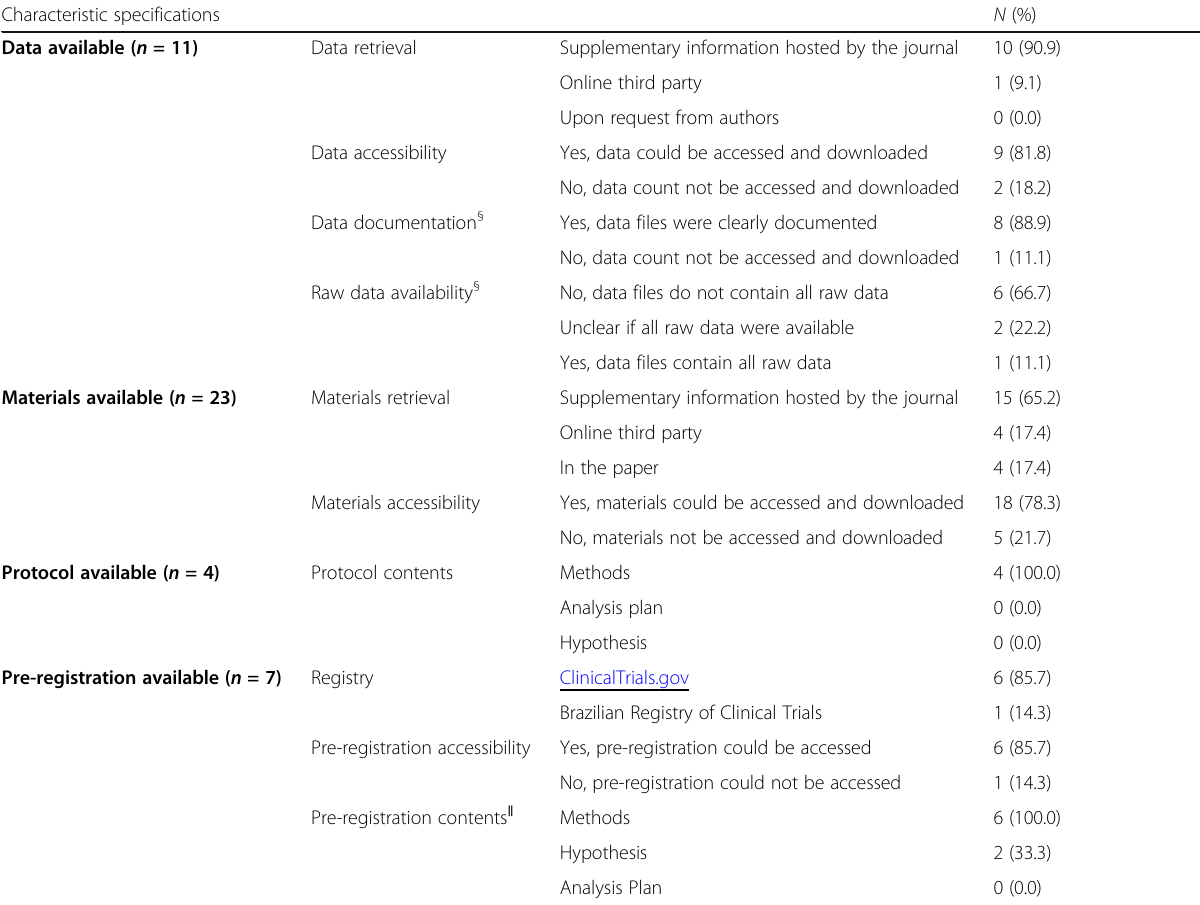
Table 4 Specifications of reproducibility-related characteristics of included publications Characteristic